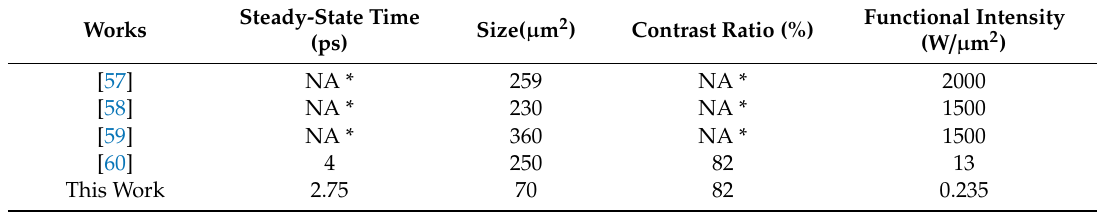
Table 1. Comparing the simulated results with ones in other